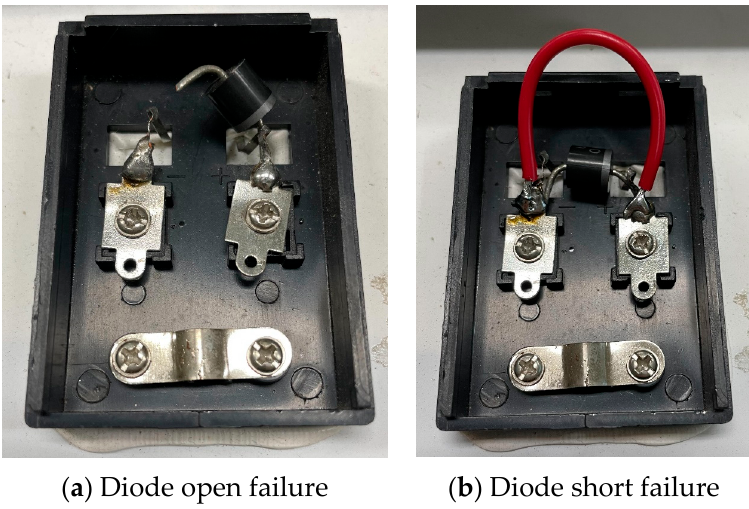
Figure 9. Bypass diode failure of the built-in PV module.